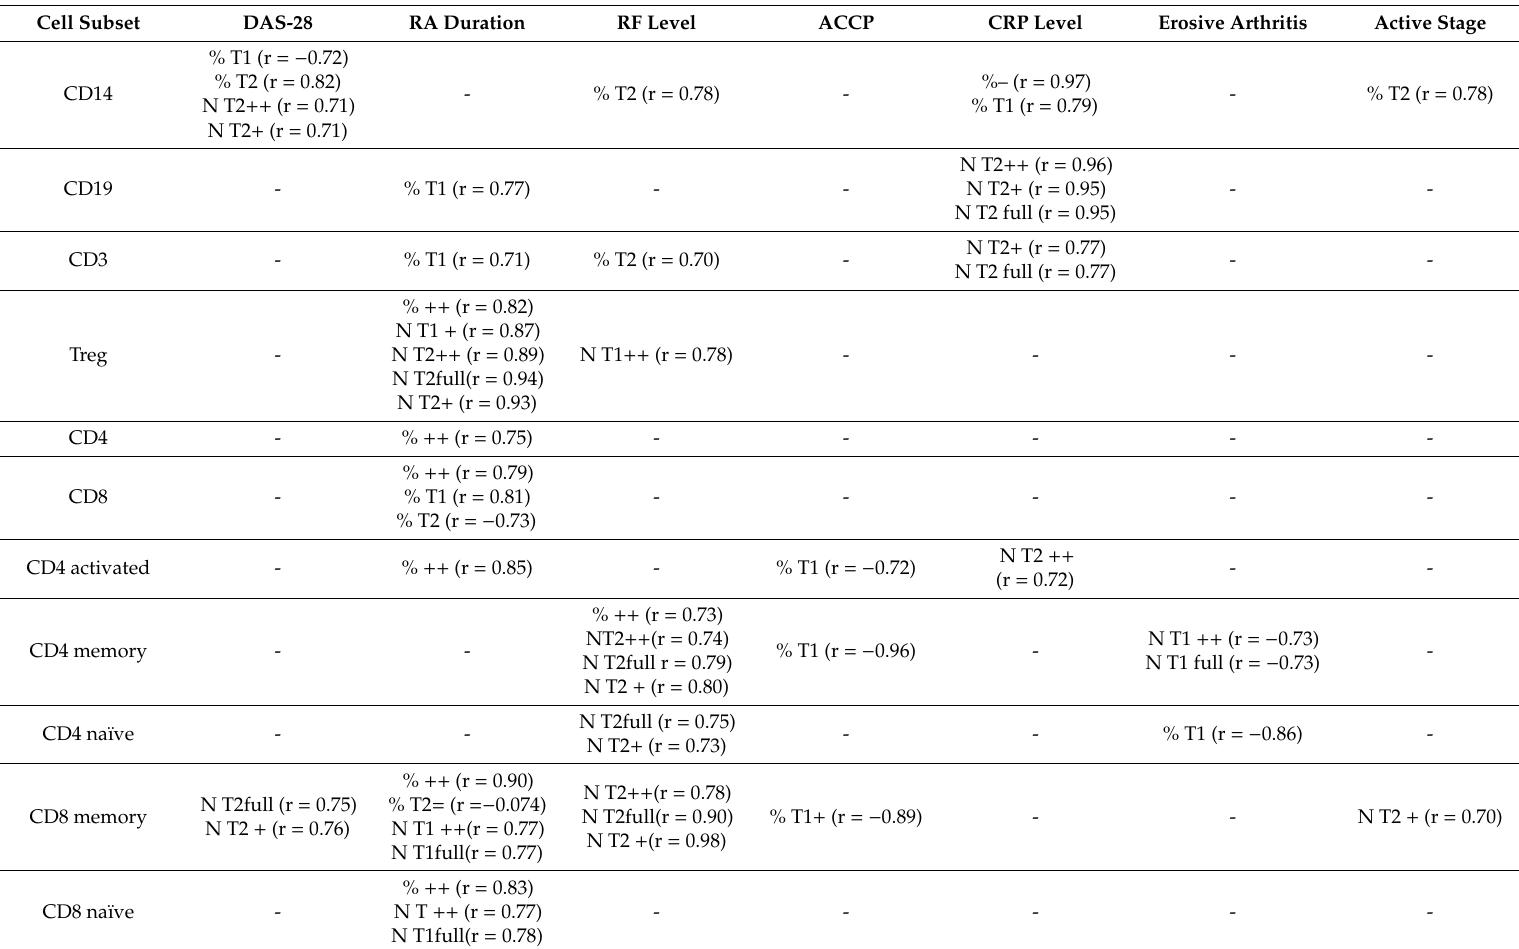
Table 2. Correlation analysis ( p <